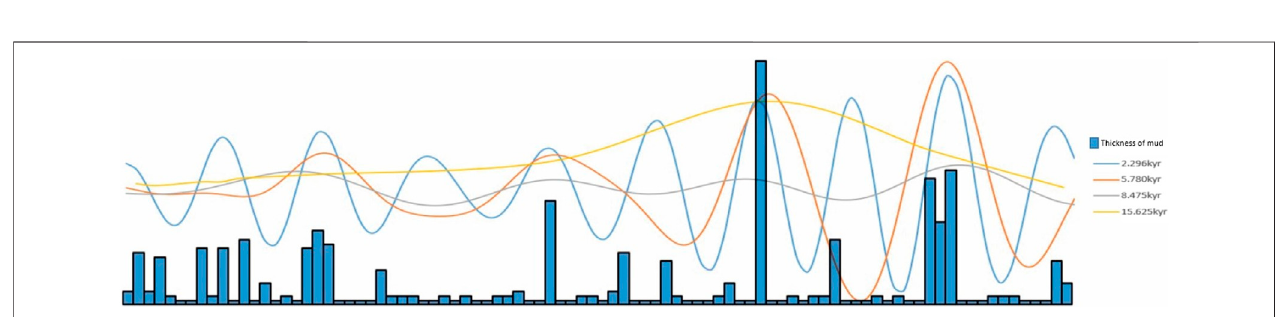
FIGURE 7 | Column chart of mudstone thickness and the time series analysis curve.